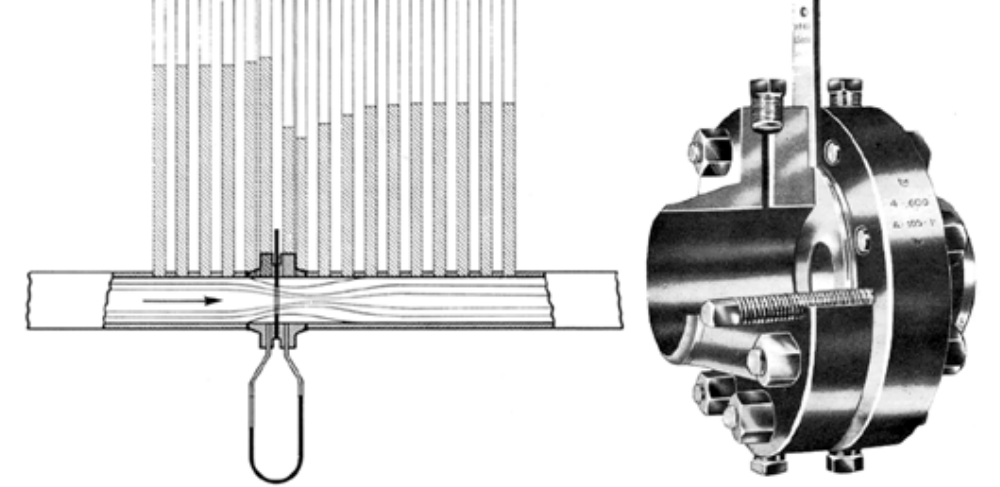
Figure 1: Flange of a steam unit